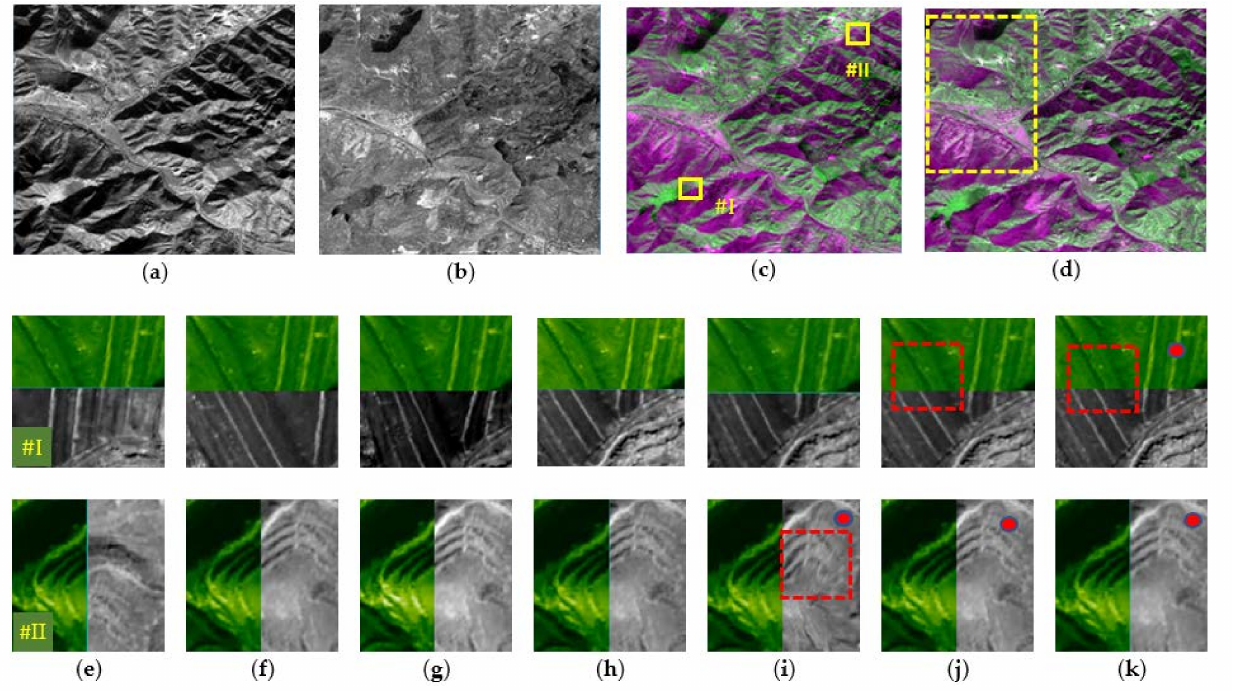
Figure 11. Registration results of image pairs in the mine production area. ( a ) Reference image (2850 × 3300 pixels). ( b ) Sensed image (2850 × 3300 pixels). ( c ) The overlap of the original images (shown in pseudo color). ( d ) The overlap of the reference image and the result of the proposed algorithm. Magnified images (180 × 180 pixels) from ( e ) the original images, ( f ) RRM, ( g ) PLM, ( h ) APAP, ( i ) OFM, ( j ) LRC-BRE-BR, and ( k ) the CCFR method. In them, the green area of the magnified images is the reference image, and the gray area is the registered image. A red point suggests that the processed image is well aligned with the reference